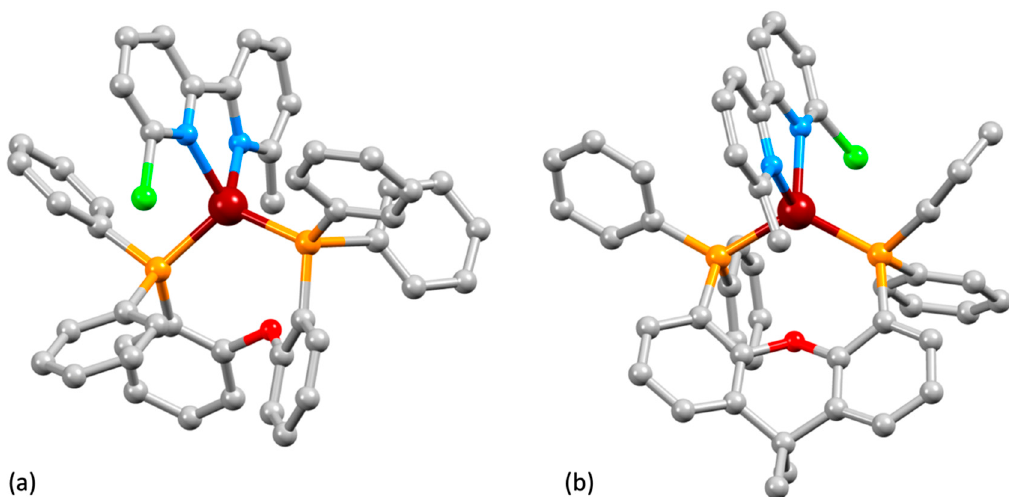
Figure 3. The structures of ( a ) the [Cu(POP)(6-Cl-6’-Mebpy)] + cation and ( b ) the [Cu(xantphos)(6-Cl- 6’-Mebpy)] + cation in the hexafluoridophosphate salts; H atoms omitted. See Figures S12 and S14 for ORTEP representations and atom labeling. The figures show only one set of disordered sites in each complex (see text).